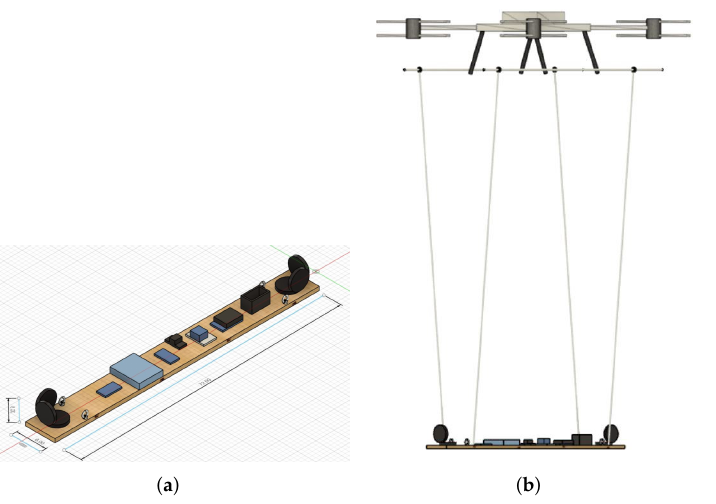
Figure 2. UAS 3D rendering. ( a ) Gradiometer sensor. ( b ) Sensor mounted to UAS.